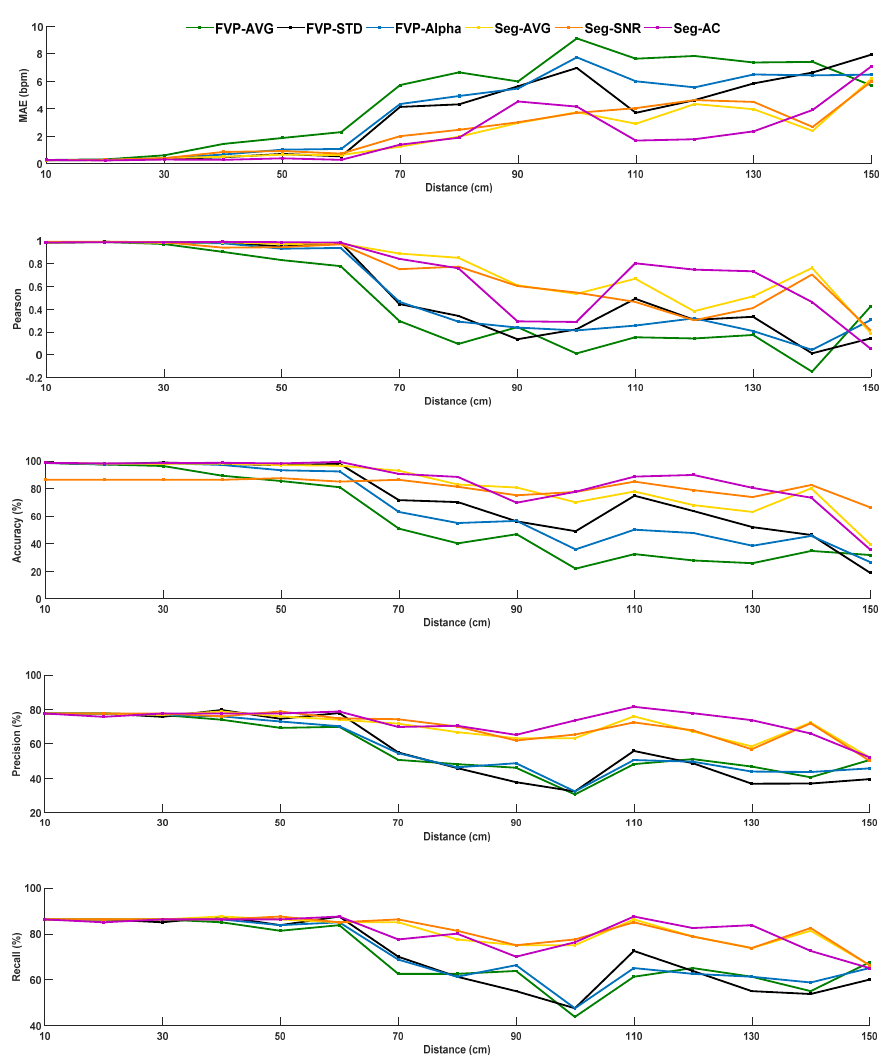
Figure 9. Statistical results obtained by six benchmarked methods on the Dataset B where subject wears a face mask under different sensor distances varying from 10 cm to 150 cm with an interval of 10